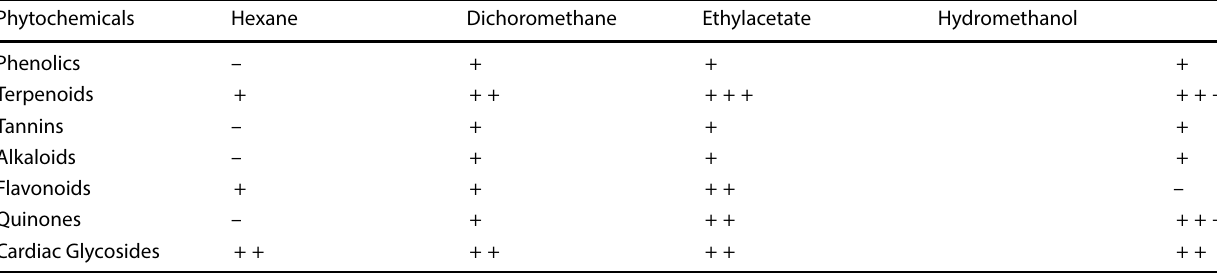
Table 2 Qualitative analysis of phytochemicals in A. floribunda fractions